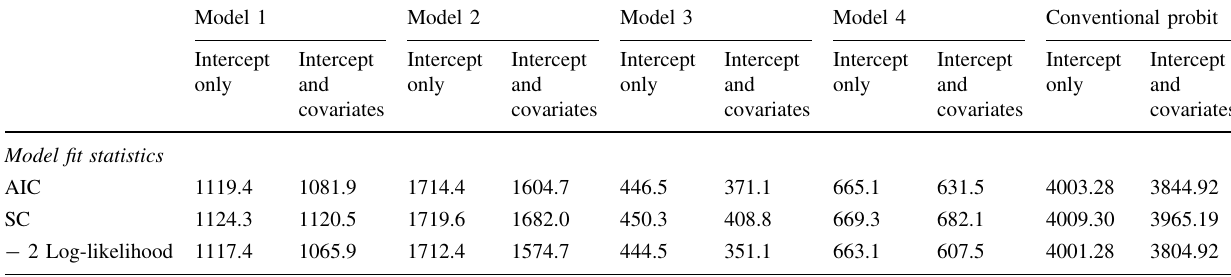
Table 4 Model fit statistics for four models obtained from probit–classification